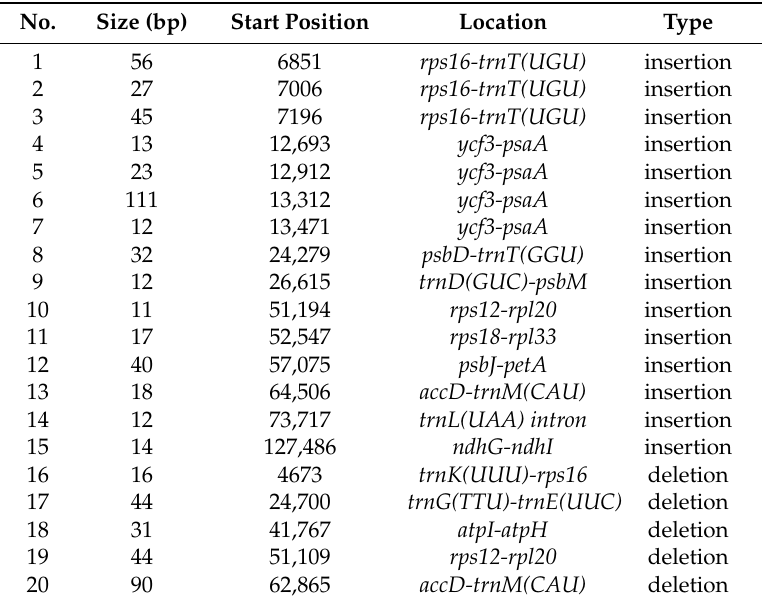
Table 2. DNA insertions and deletions with more than 10 nucleotides in the chloroplast genomes of Eucommia ulmoides